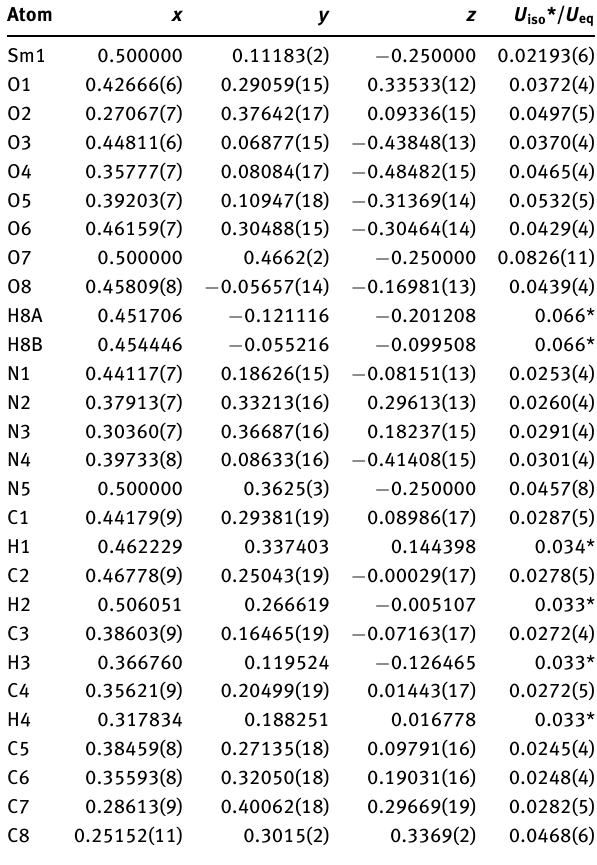
Table 2: Fractional atomic coordinates and isotropic or